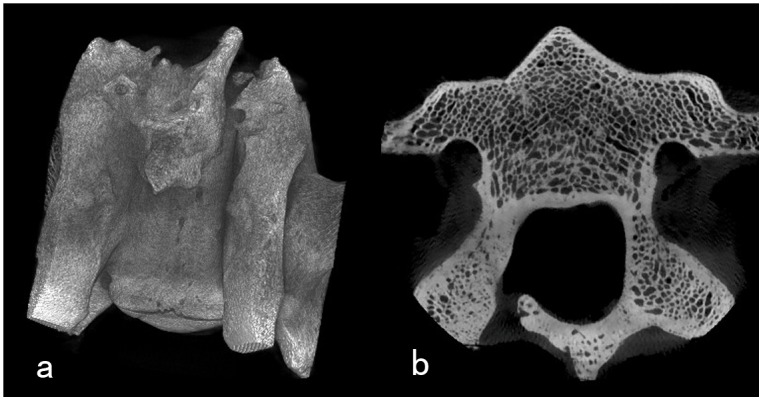
Micro-CT examination of the postoperative vertebra six months after surgery.a demonstrate the unilateral fusion of the lamina, and the length of the lamina is also minished. b demonstrate the bone density of the residual lamina was visually almost the same as the vertebral arch with no intervention.